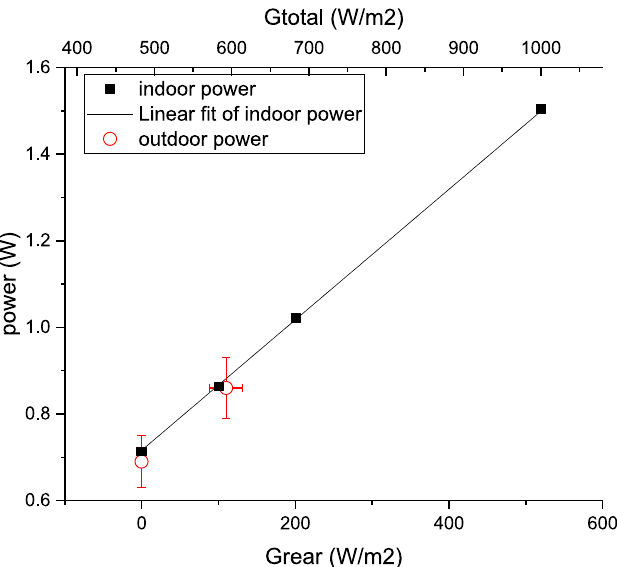
Fig. 9. Outdoor performance compared to indoor performance at 1000 W/m 2 of the rear component only. G rear is the additional rear irradiance. G total is the corresponding total irradiance from the rear only to achieve the necessary injection level. The module temperature is uncontrolled and varies between 5 and 39 ° C, due to outdoor temperature variations between 2 and 21 ° C. The error bars are at k = 2 of all measurement data points. Approximately 400 datapoints are contained in each outdoor data